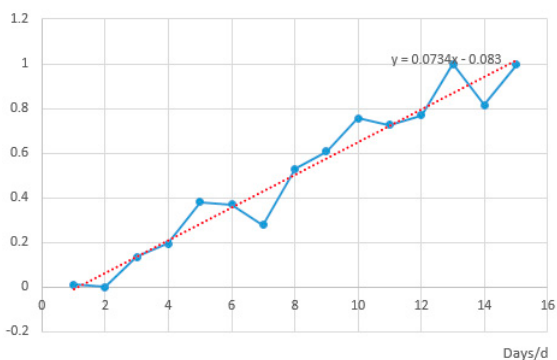
Figure 9. Original Standard deviation chart.